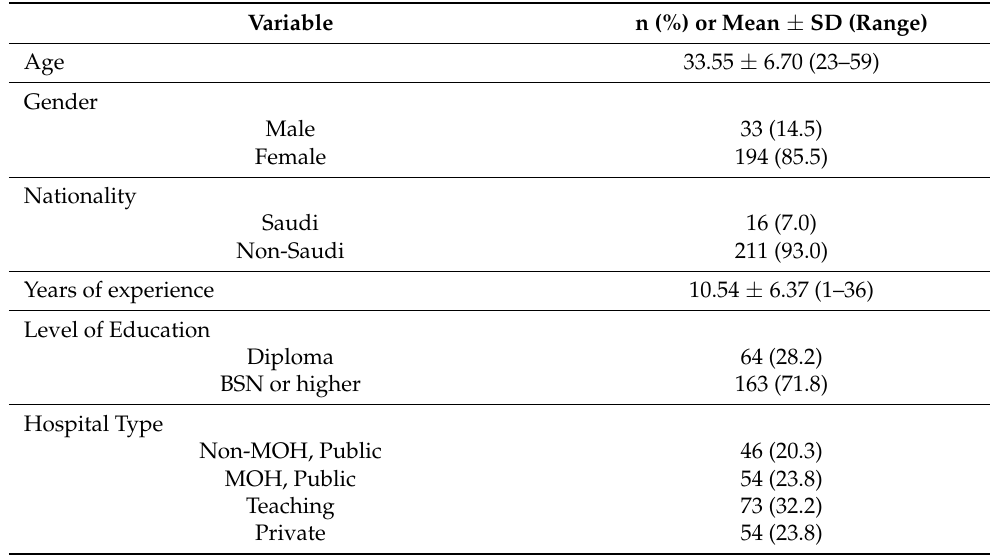
Table 1. Sample characteristics and organizational factors (N =